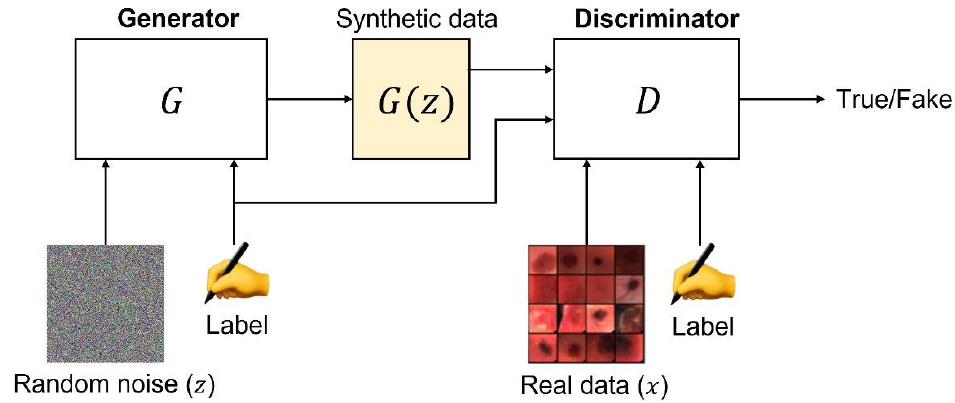
Figure 5. The cGAN architecture.